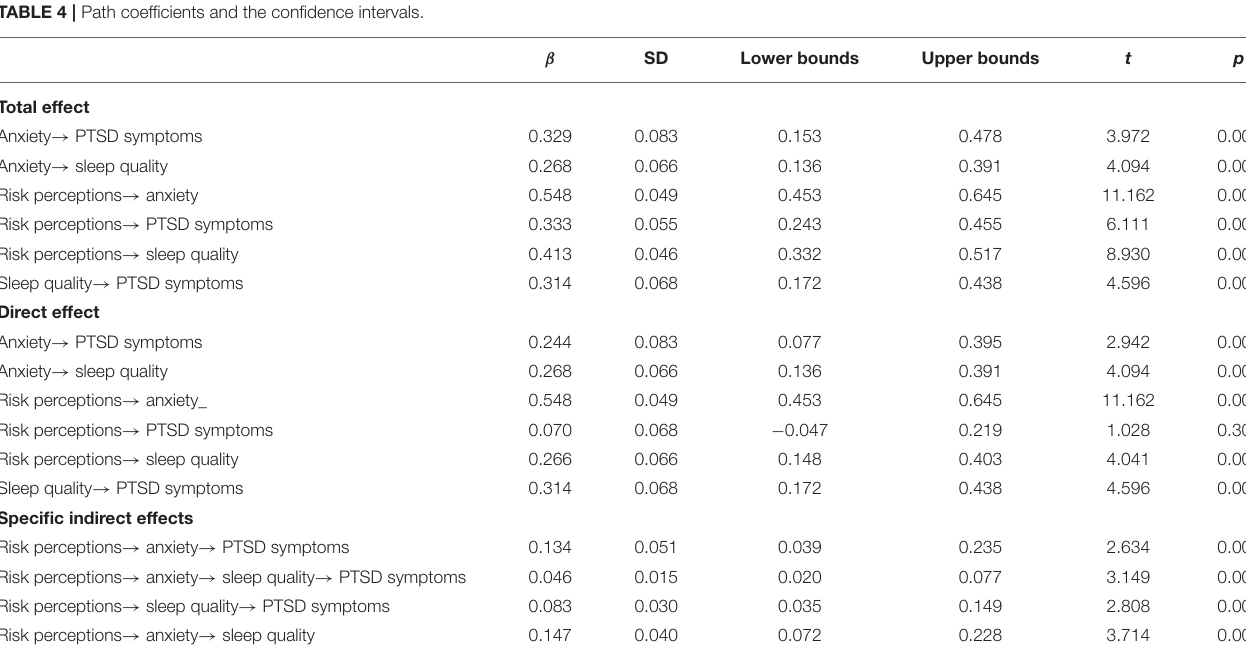
TABLE 4 | Path coefficients and the confidence intervals. β SD Lower bounds Upper bounds t